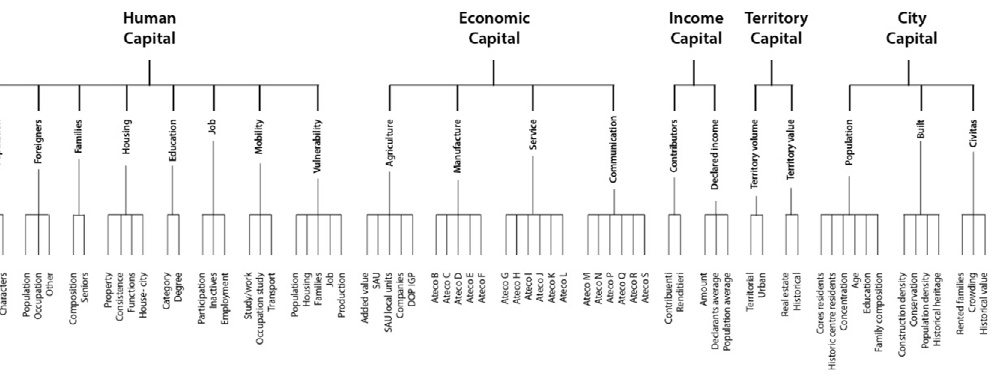
Figure 5. The dendrogram for the description, valuation and interpretation of the life quality within the territorial-urban relational space of the Province of Enna.